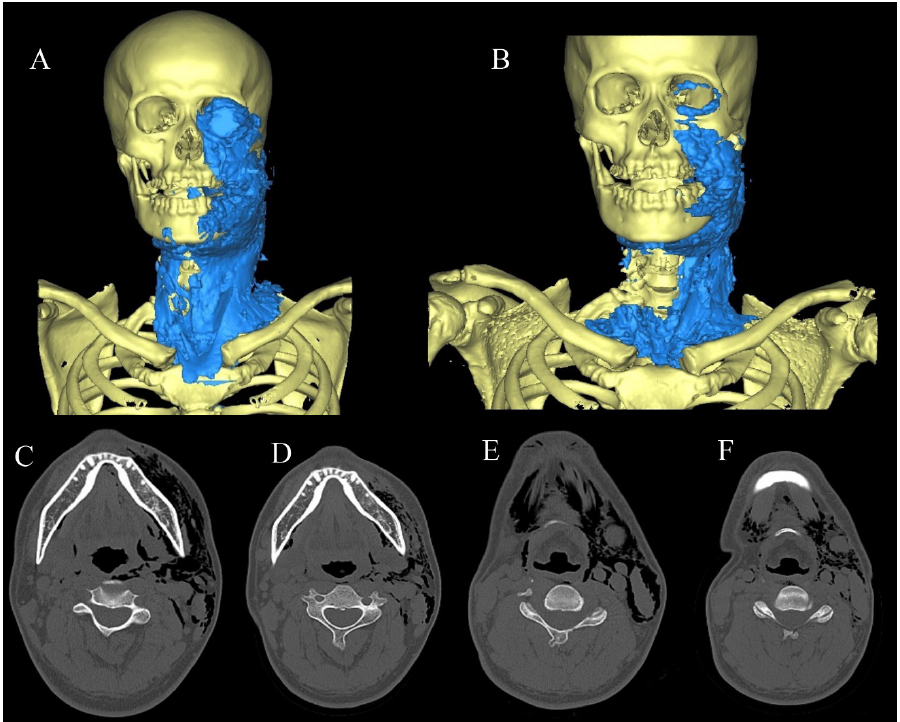
Figure 7. ( A ) 3D model based on the CT taken at the first visit. The volume was measured to be about 376 mL. ( B ) 3D model on the 3rd day after injury. The volume was measured to be about 204 mL. ( C , D ) the CT taken at the first visit. ( E , F ) CT findings 3 days after injury. Healthcare 2022 , 10 , x FOR PEER REVIEW